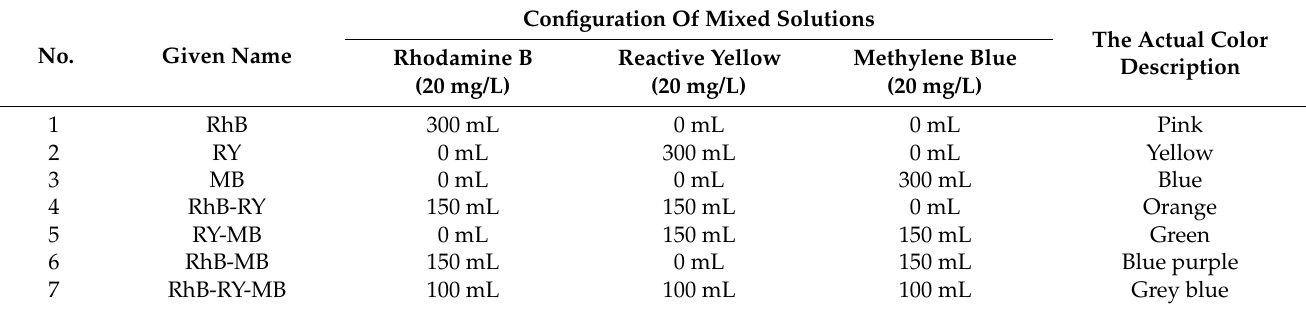
Table 1. Configuration of different color